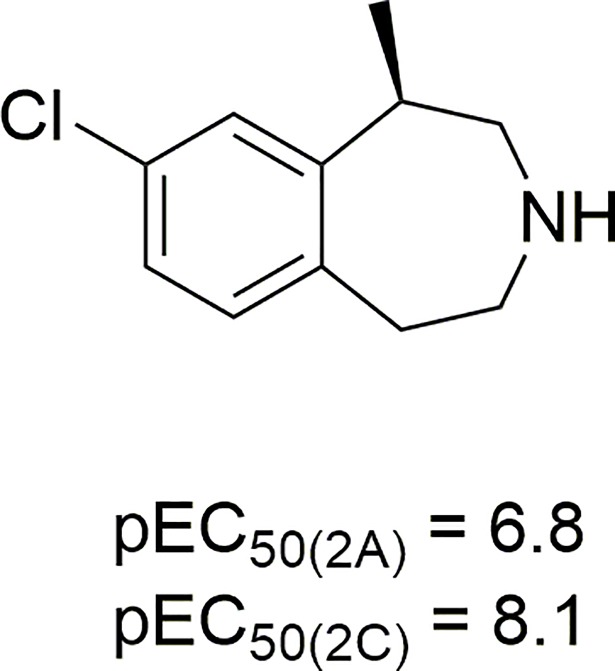
Structure and 5-HT2A and 5-HT2C functional potencies of lorcaserin.